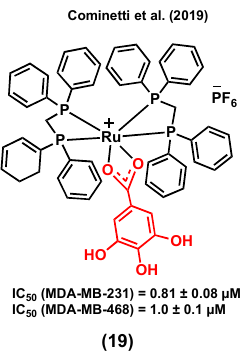
Figure 7. A ruthenium complex bearing gallic acid (GA).